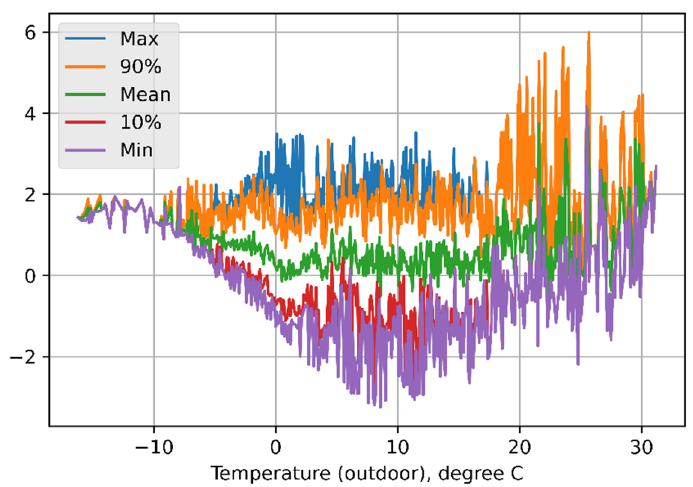
Figure 11. Average moisture excess in Krimulda church on the balcony. Figure 12. Average, oisture excess in Krimulda church on the external Figure 12. Average ,oisture excess in Krimulda church on the external wall.